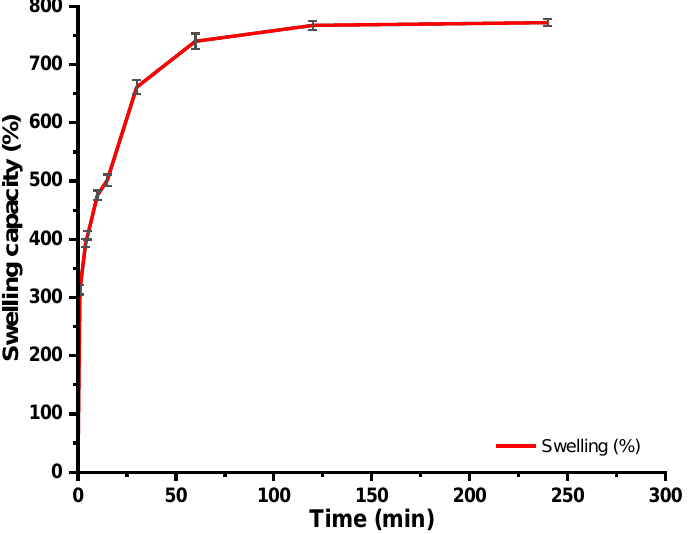
Figure 2. Swelling capacity as a function of time.